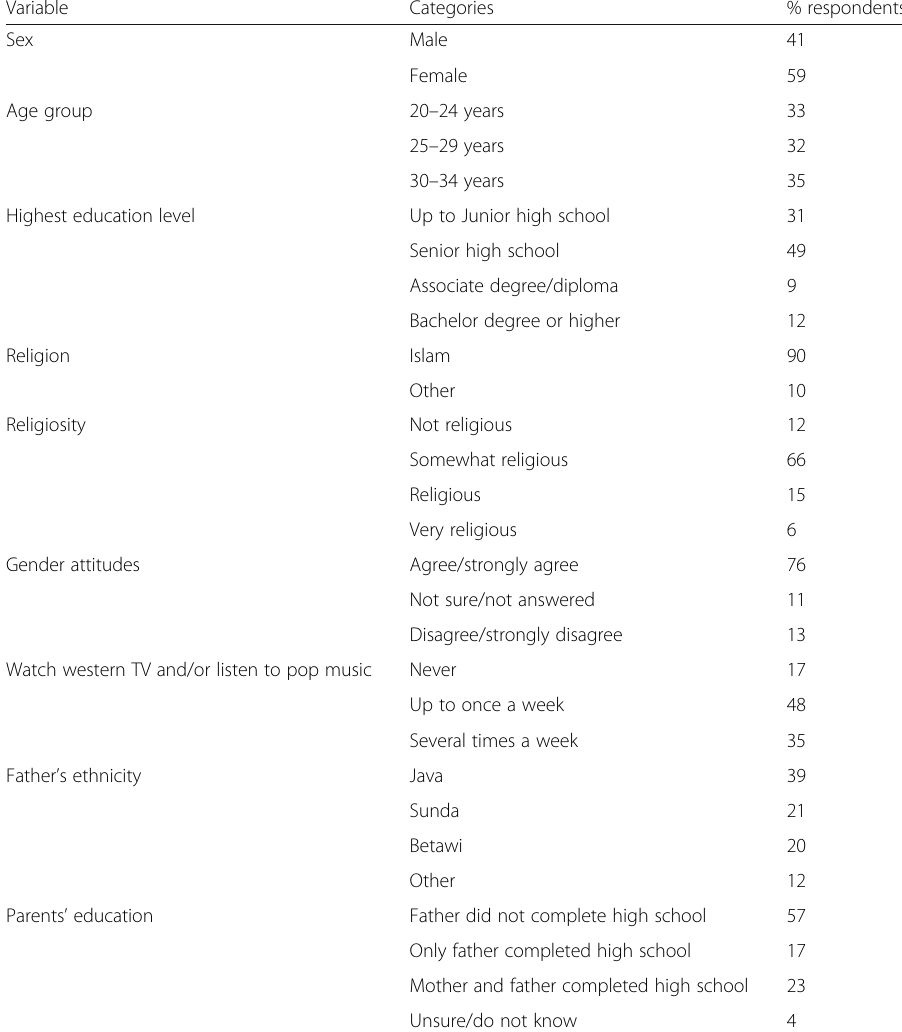
Table 1 Associates with reporting of premarital sexual intercourse and activity